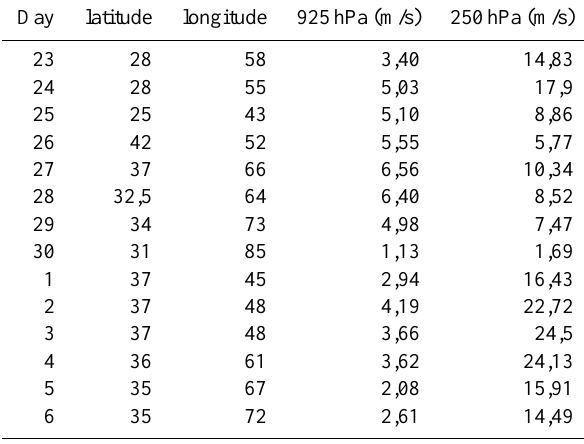
Table 1. Location of the center of the south Indian anticyclone and the zonal winds as function of the day at 925 hPa and at 250 hPa